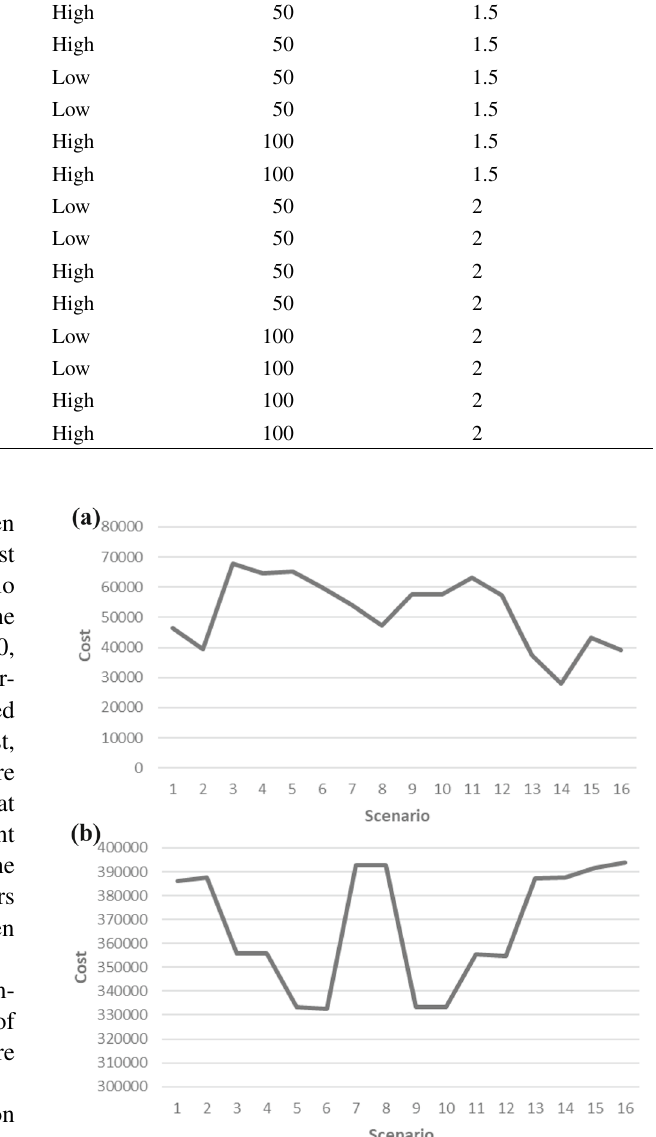
Scenario The rate of customers being affected by advertising